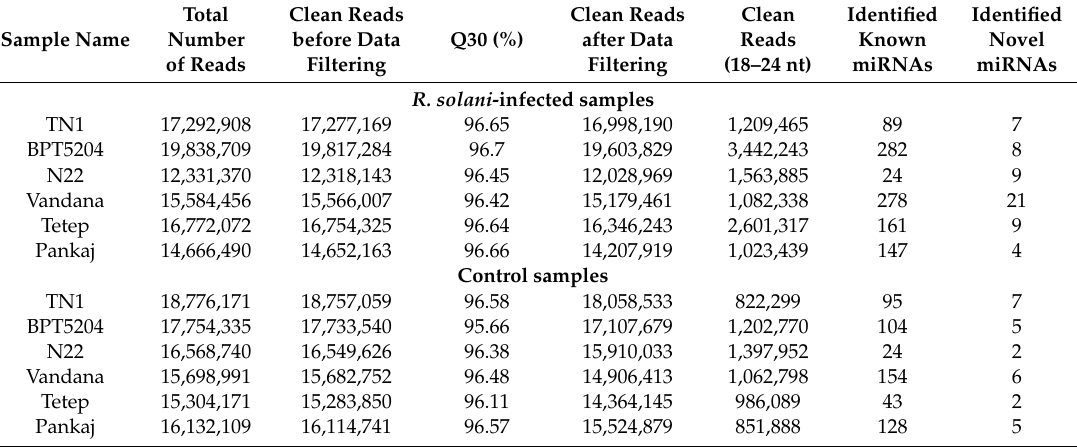
Table 1. Summary of the small RNA sequencing and analysis of control and Rhizoctonia solani -infected rice